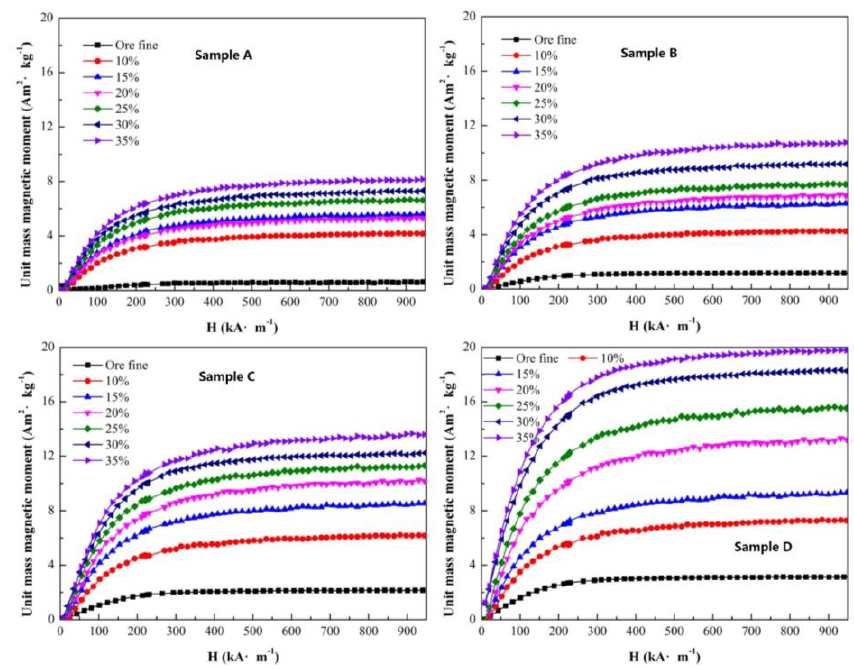
Figure 9. The unit mass magnetic moment of sample A to D with different CO